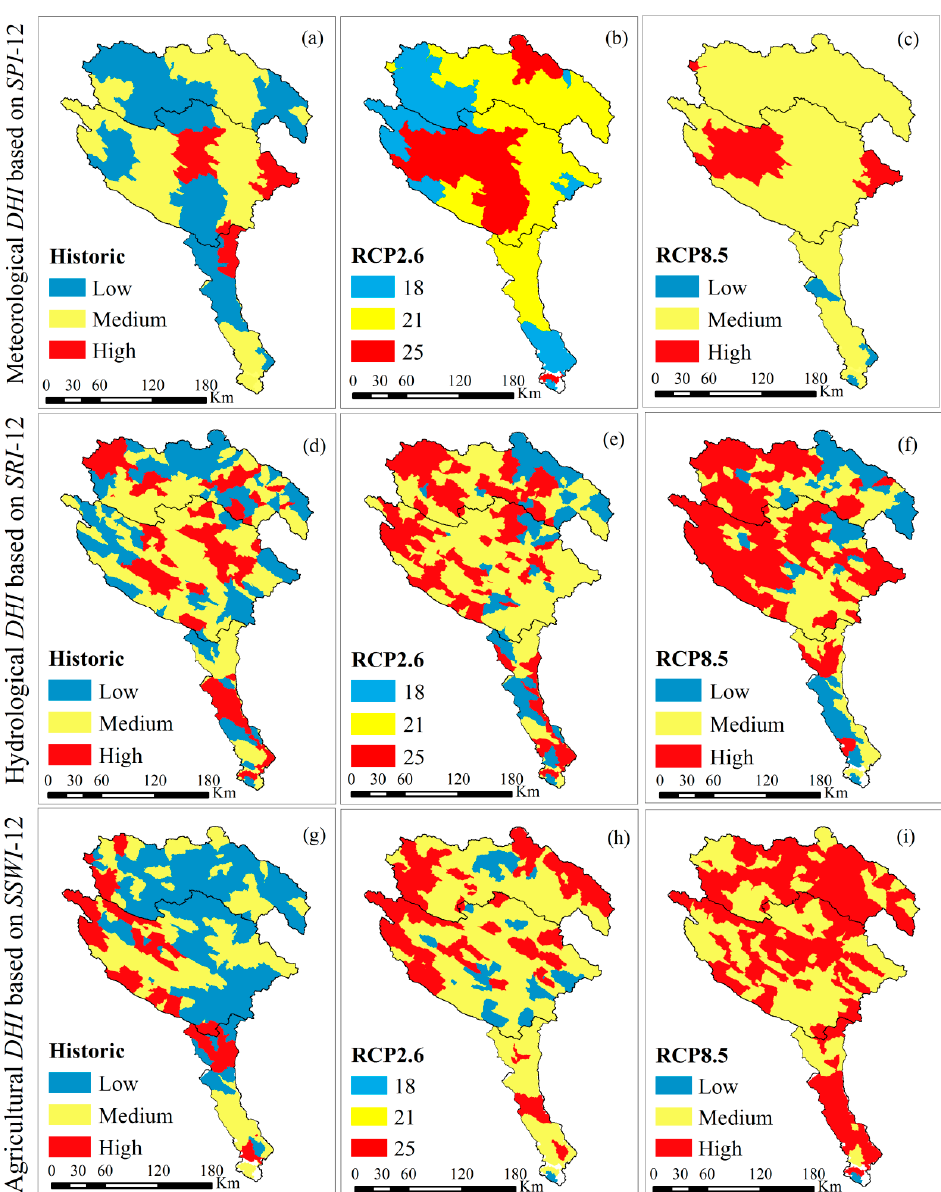
Figure 5. Spatial variations of meteorological DHI ( a – c ), hydrological DHI ( d – f ), and agricultural DHI ( g – i ) comparing the historic and future variations in RCP2.6 and RCP8.5. The results are obtained from an ensemble of five GCMs.